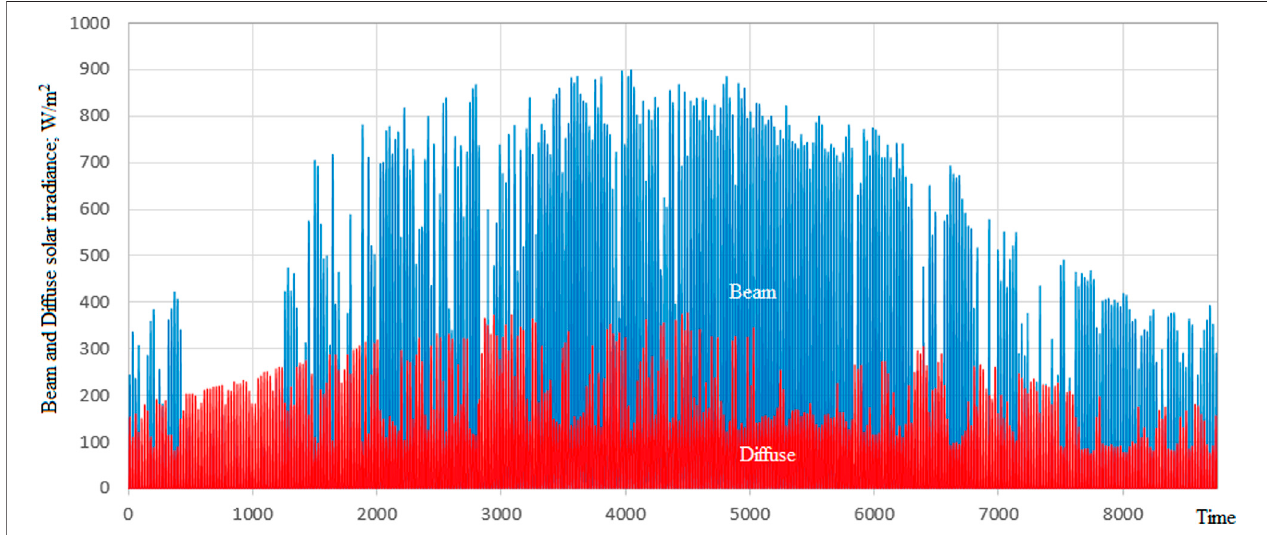
FIGURE 18 | Hourly horizontal beam and diffuse solar irradiance for Ankara (40 . 05 ° N , 32 . 867 ° E).